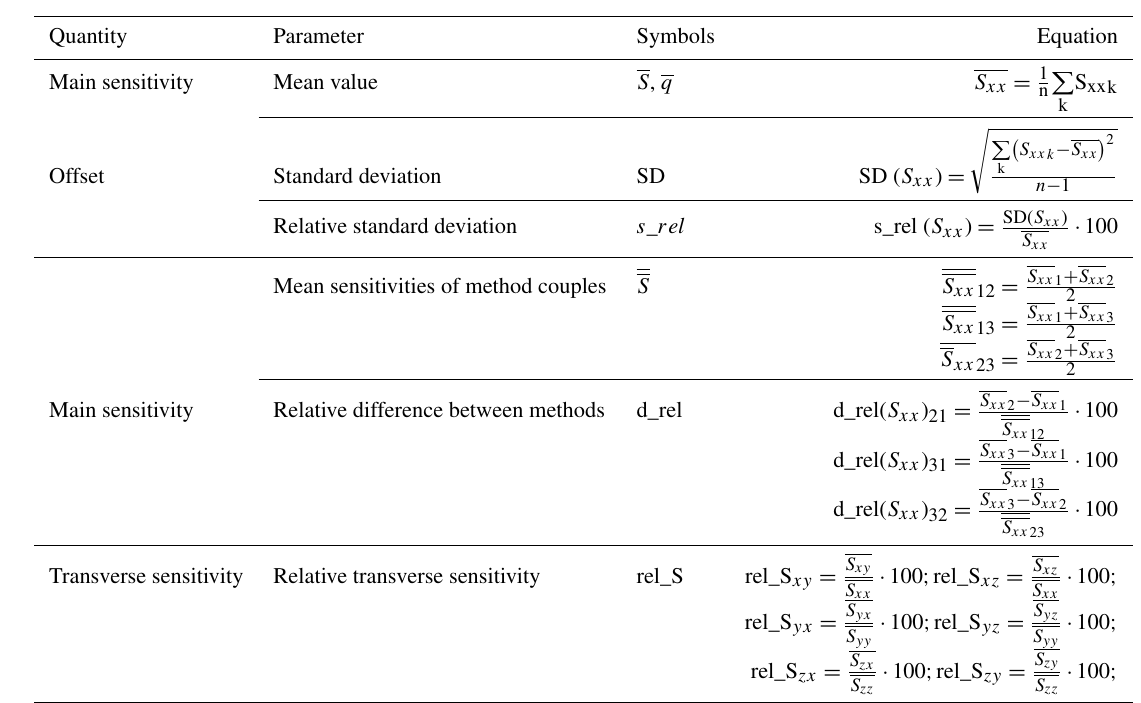
Table A1. Parameters used for the comparison: symbols and